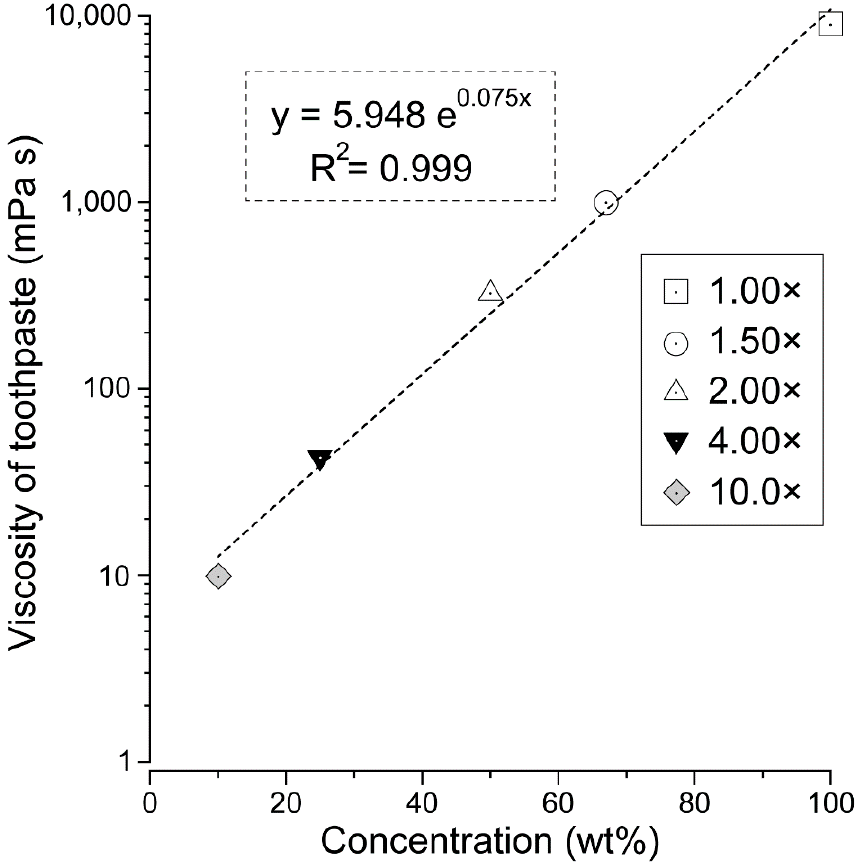
Figure 2. Relationship between toothpaste concentration and viscosity. The viscosity and correlation of each toothpaste concentration (1.00×, 1.50×, 2.00×, 4.00×, and 10.0×) are shown. The white square indicated dentifrice with a concentration of 100% (1.00×). White circles: 67% (1.50×); white triangles: 50% (2.00×); black inverted triangles: 25% (4.00×); gray diamonds: 10% (10.0×). A scatter plot was created with the logarithmic value of viscosity on the vertical axis and the concentration (%) on the horizontal axis. It was found that there was a strong positive correlation between toothpaste concentration and viscosity ( r = 0.999).